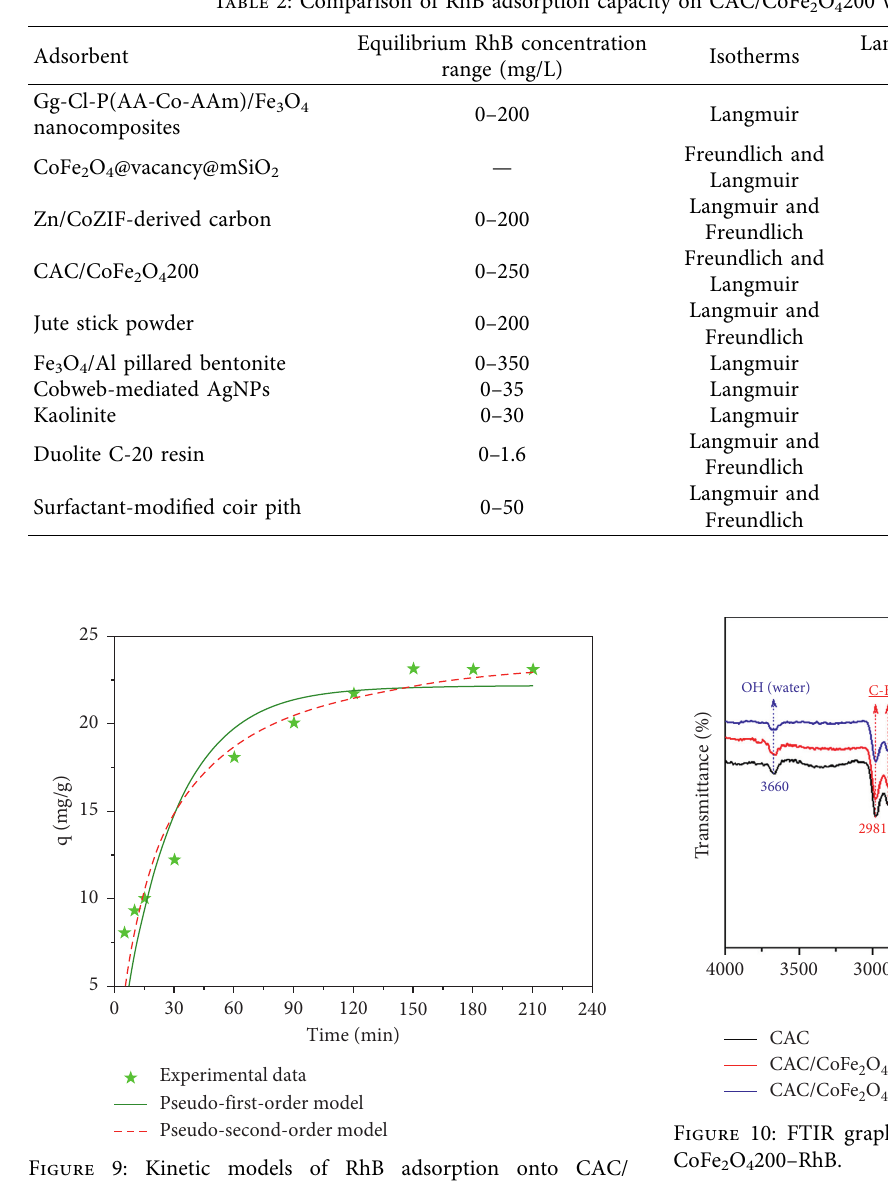
2 O 4 200 with other adsorbents.